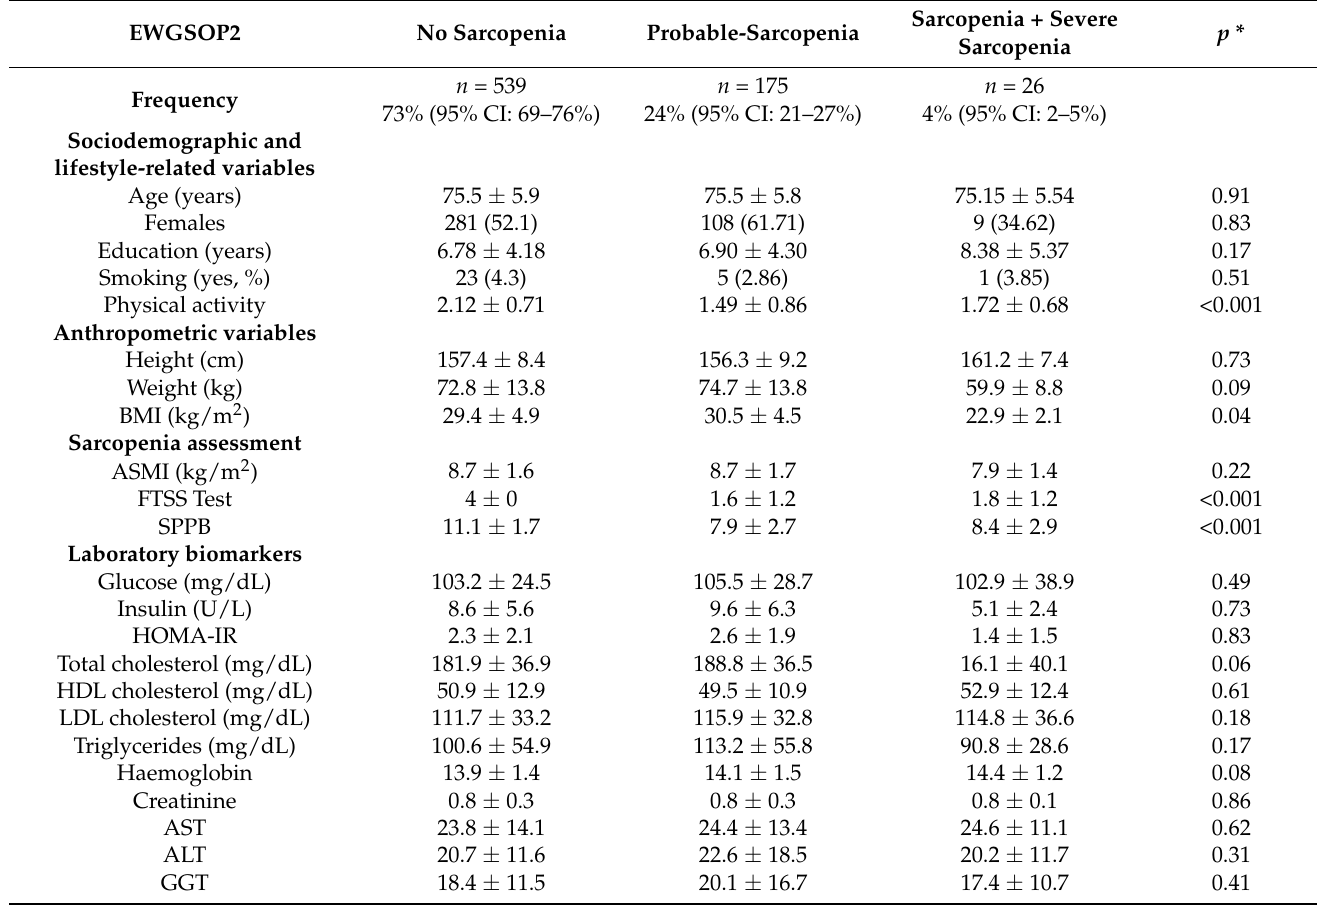
Table 5. Sociodemographic, lifestyle-related, anthropometric, sarcopenia-related, and laboratory biomarker characteristics according to the different sarcopenia-related categories, European Working Group on Sarcopenia in Older People 2019 (EWGSOP2) using appendicular skeletal muscle index (ASMI) to define muscle mass. The Salus in Apulia Study ( n = 740). EWGSOP2 No